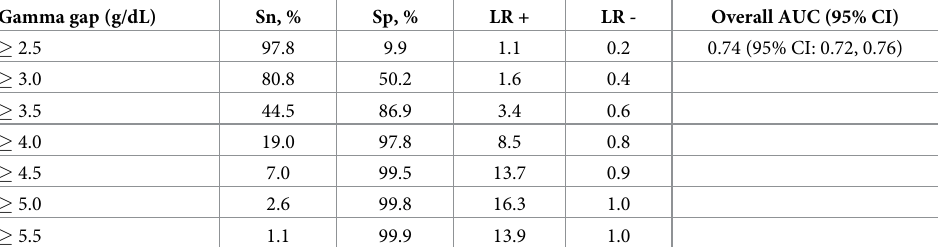
Table 3. Diagnostic performance of gamma gap for HCV using different gamma gap threshold, N = 45,134. Gamma gap